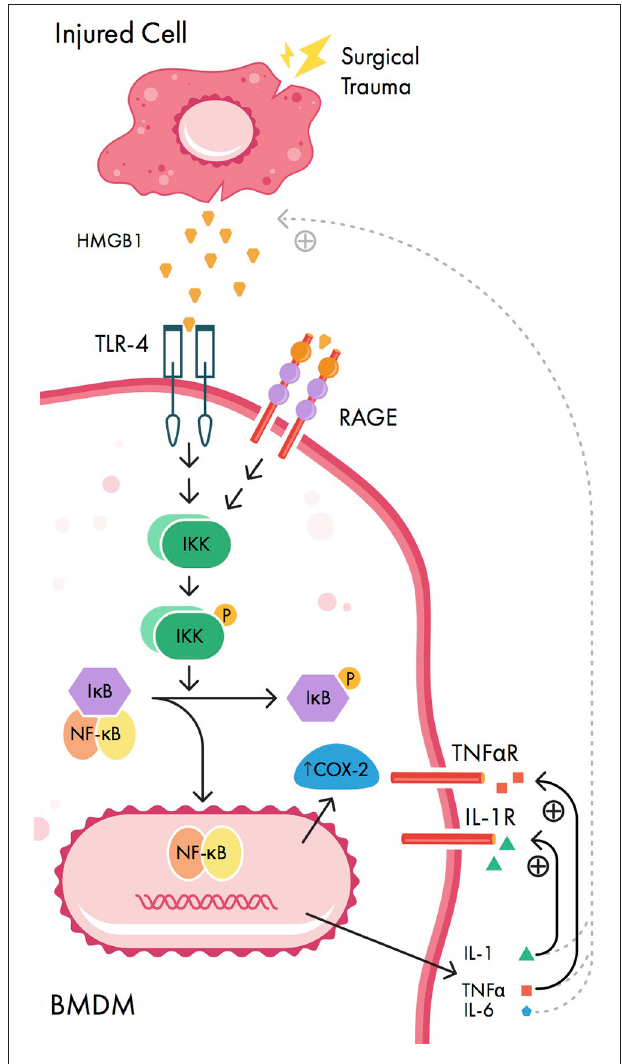
FIGURE 1 | Signaling pathways involved in peripheral initiation of inflammation. Injured cells release damage-associated molecular patterns (DAMPs) including high mobility group box-1 protein (HMGB1) in response to surgical trauma. HMGB1 activates nuclear factor-kappa B (NF- κ B) signaling pathways in bone marrow derived monocytes (BMDMs), causing nuclear translocation of NF- κ B, increased expression of cyclooxygenase 2 isozyme (COX-2) upregulation, and expression of pro-inflammatory cytokines interleukin-1 beta (IL-1 β ), interleukin 6 (IL-6), and tumor necrosis factor alpha (TNF α ). These pro-inflammatory cytokines can act back on BMDMs in positive feedback loops (solid curved lines) as well as promote further release of HMGB1 from injured cells by unknown mechanisms (dashed curved lines). IKK, I κ B kinase; IL-6R, IL-6 receptor; P, phosphate group; RAGE, receptor for advanced glycosylation end products; TLR-4, Toll-like receptor 4; TNF α R, TNF α